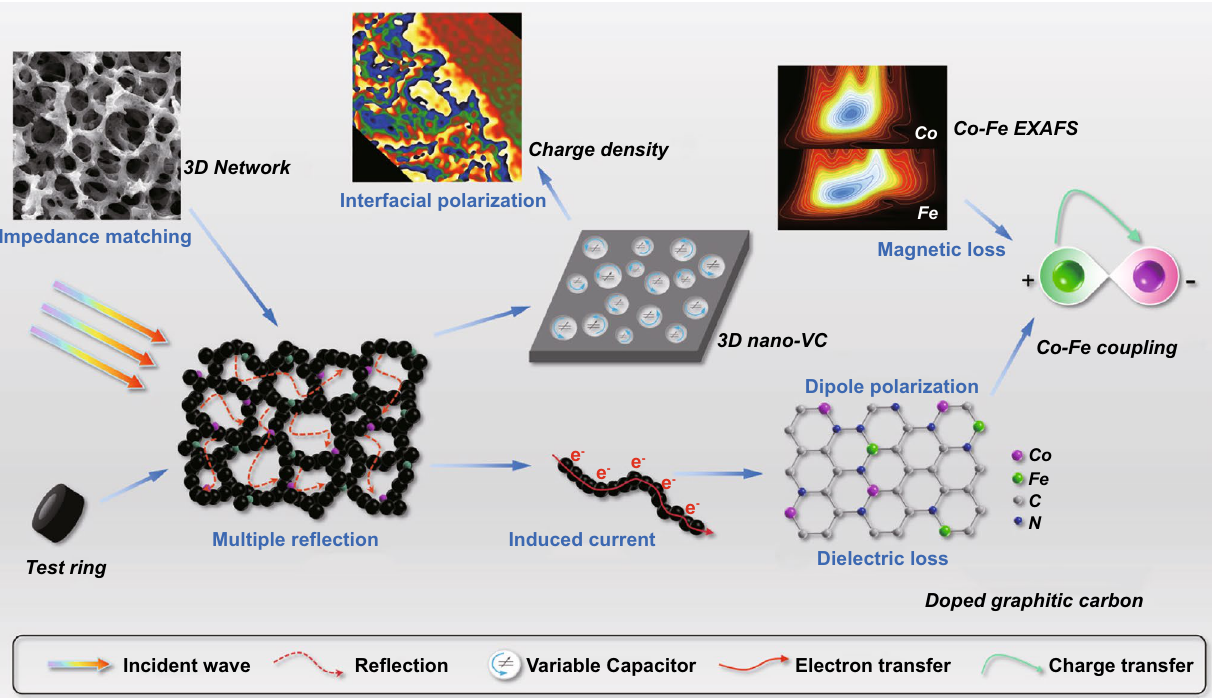
Fig. 5 Schematic diagram of the electromagnetic wave adsorption mechanism for